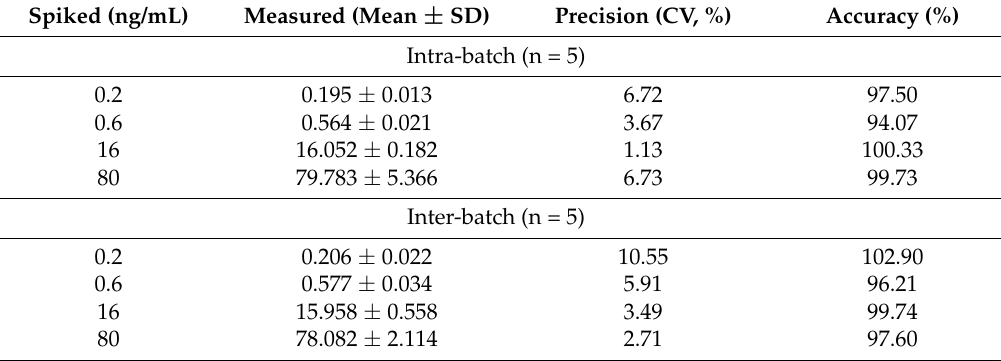
Table 1. Precision and accuracy of UPLC-MS/MS analysis for the determination of KAU in human plasma. Spiked